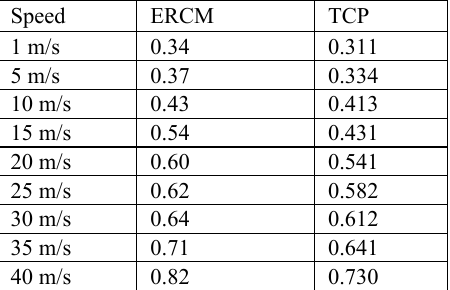
Table 3. Fairness index comparison of ERCM and TCP.